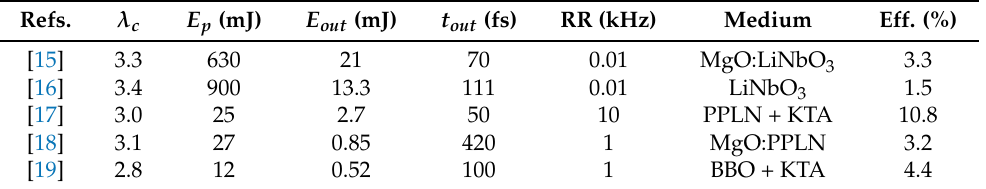
Table 4. Comparative parameters for selected mJ-level laser systems at 3 µ m, ordered by output pulse energy. λ c is the central wavelength, E p the pump energy, E out the output energy, t out the output pulse duration, and RR the pulse repetition rate.